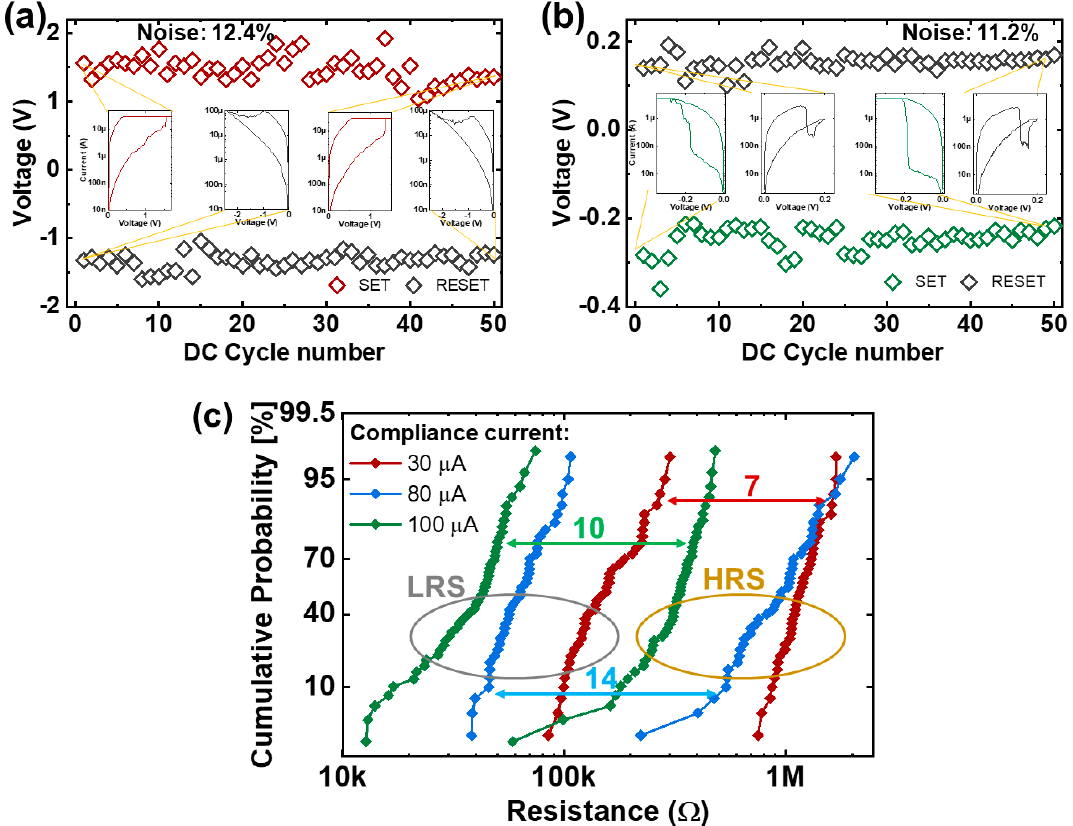
Figure 4. Programming voltage fluctuation for ( a ) Pt- and ( b ) graphene-based VRRAMs. Inset: I-V characteristic of the 1st and last sweep for SET and RESET. ( c ) Cumulative probability of the resistance distribution in the VRRAM with a conventional metal electrode programmed at various compliance currents.